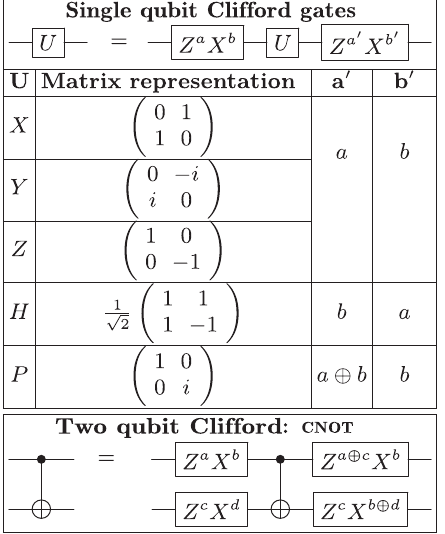
FIG. 1. Key transformation under Clifford gates. In circuit diagrams above, Z a X b and Z a 0 X b 0 are encrypting and decrypting maps performed by Alice. The symbol ⊕ denotes addition modulo